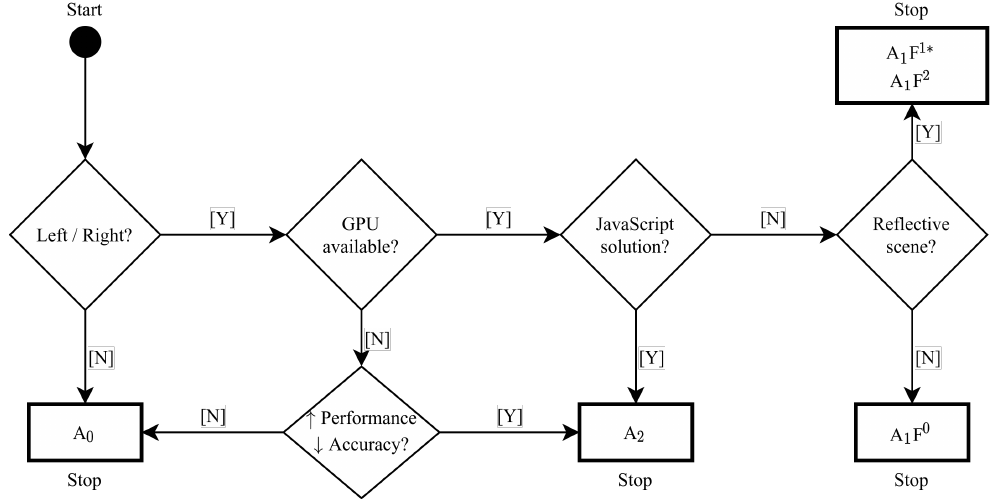
Figure 10. Decision support flow chart for choosing between the five HPE-CNNs. Start with the circle in the top left corner. Diamonds represent decisions and must be answered with [Y]es or [N]o ( ∗ , with implemented